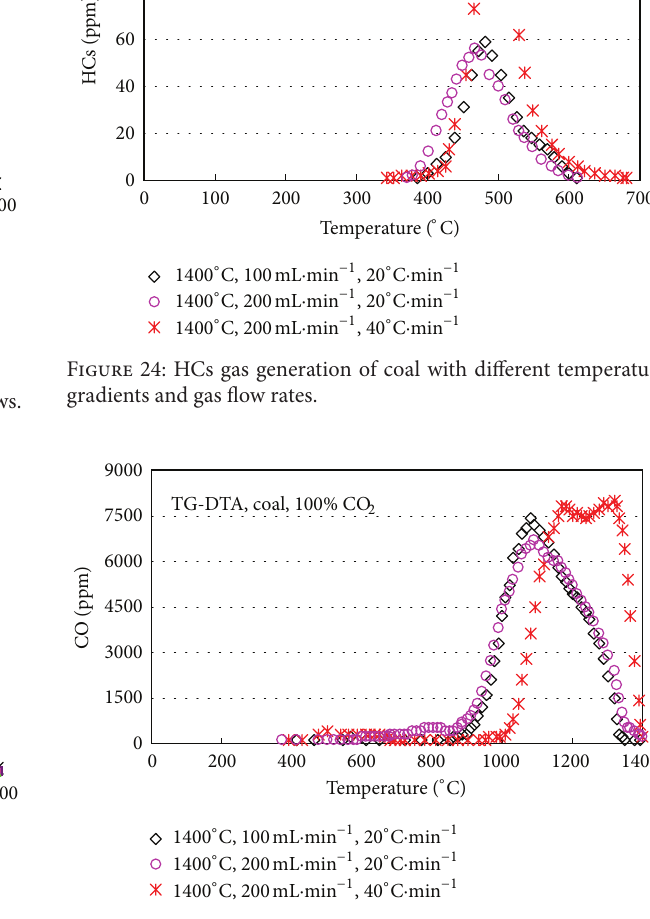
Figure 25: CO gas generation of coal with different temperature gradients and gas flow